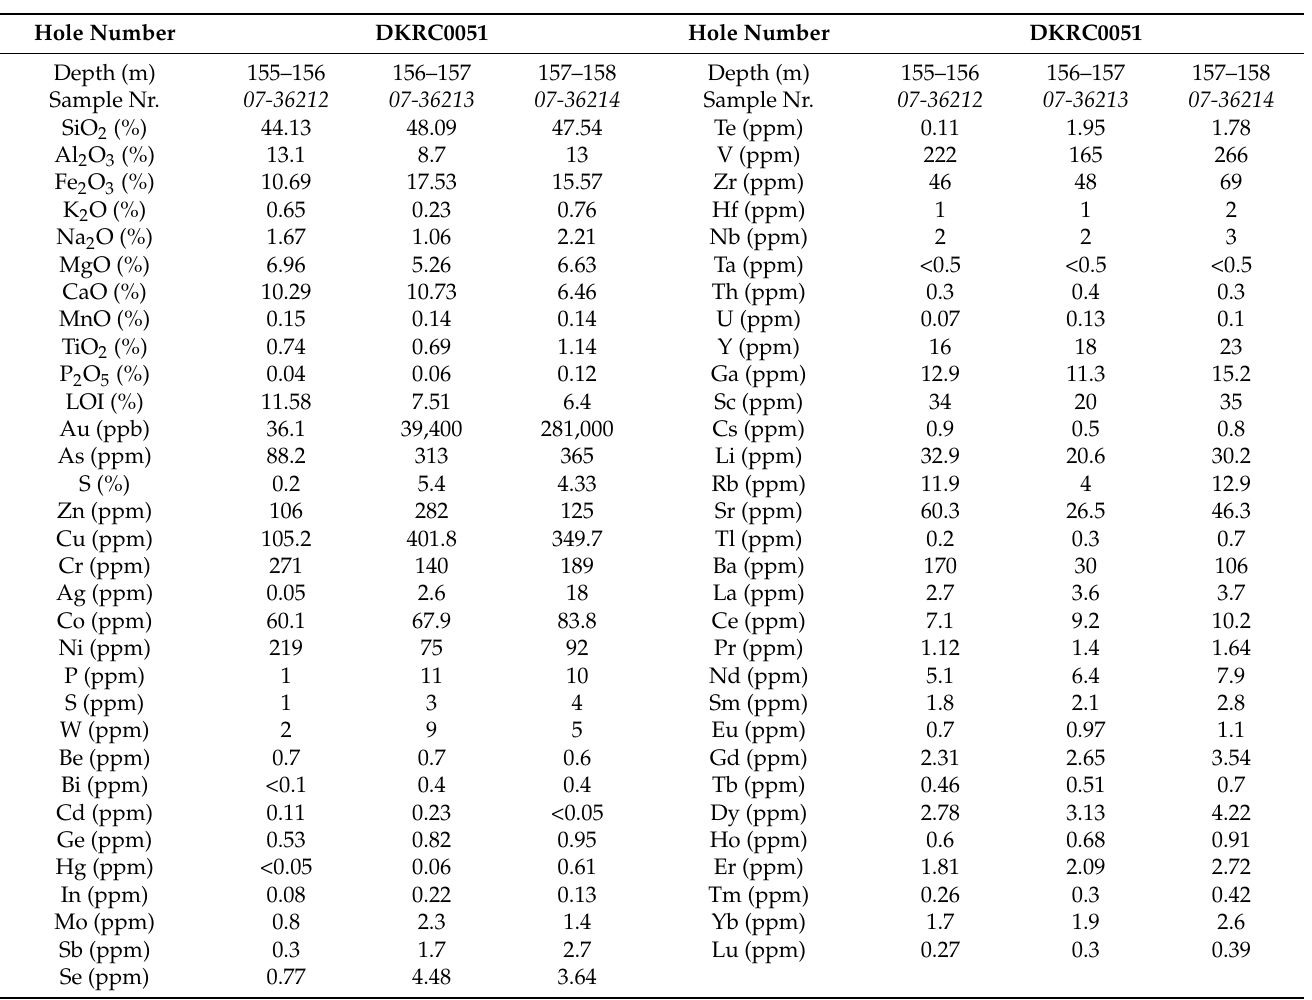
Table 2. Multi-element chemical analyses completed on the bulk rock of three samples from the mineralization intersected in drill hole DKRC0051 at a depth between 155 and 158